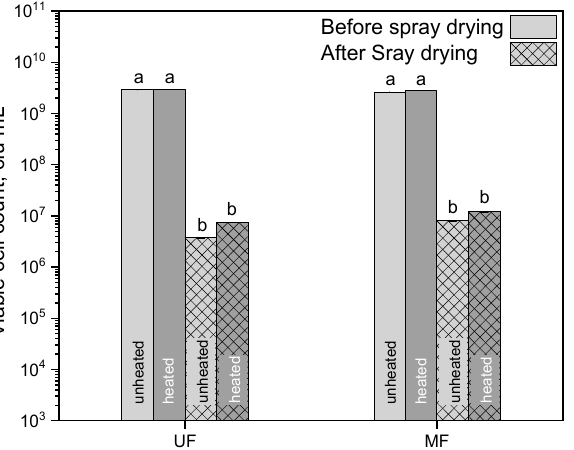
Figure 2. Viable cell count before and after spray drying of UF and MF. The standard deviations of all samples before spray drying were ± 5 × 10 4 cfu mL − 1 and after spray drying 2 × 10 3 cfu mL − 1 (presented, but not visible due to scale). Letters indicate the statistical significance at p ≤ 0.05.